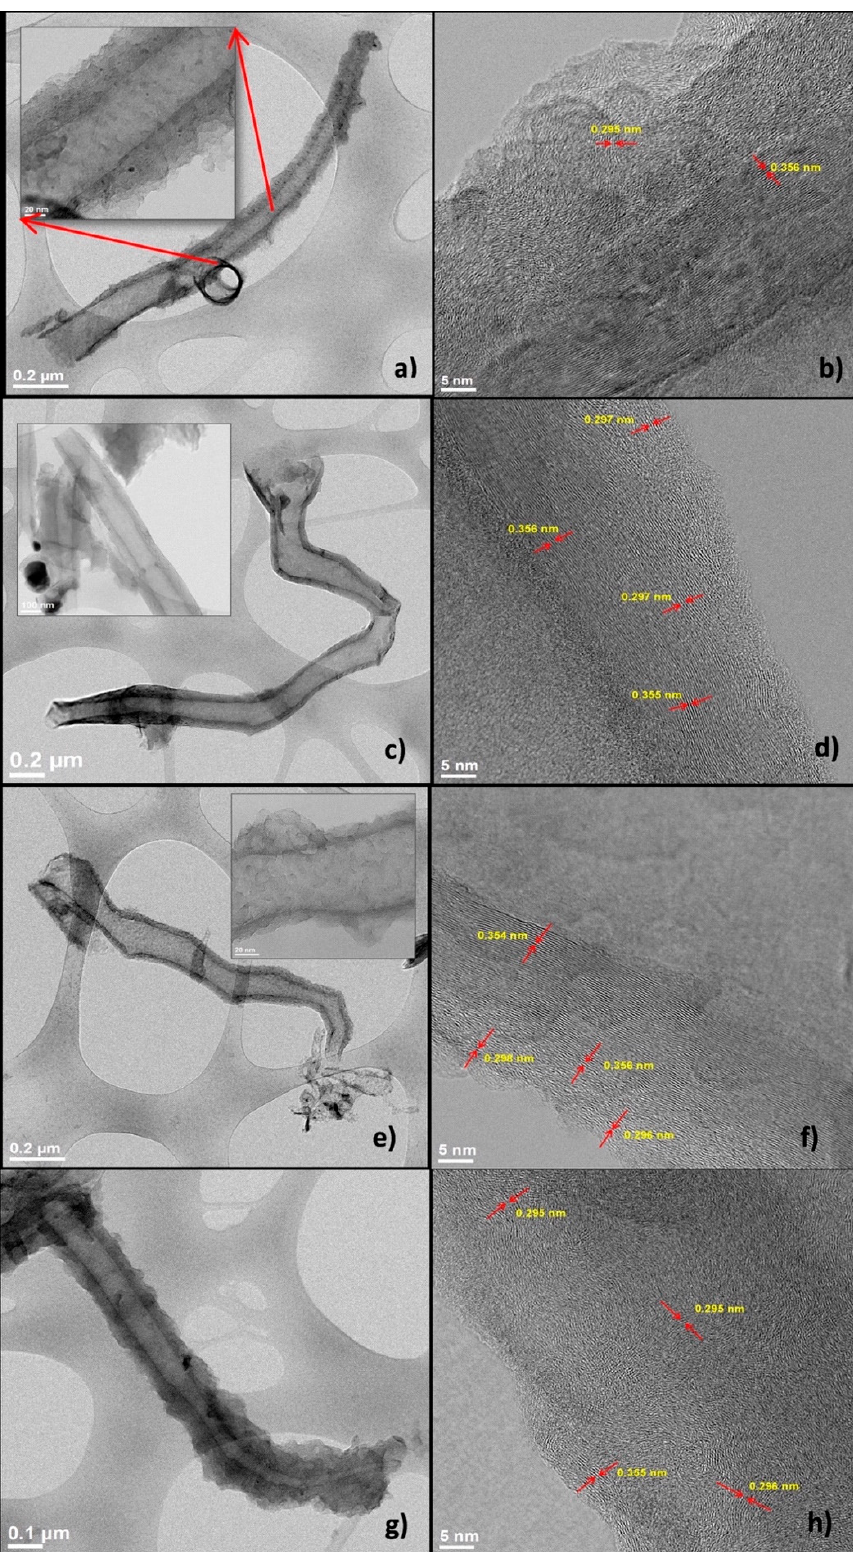
Figure 5. TEM images of SCNA8 ( a , b ), SCNA9 ( c , d ), SCNB8 ( e , f ), and SCNB9 ( g , h ).